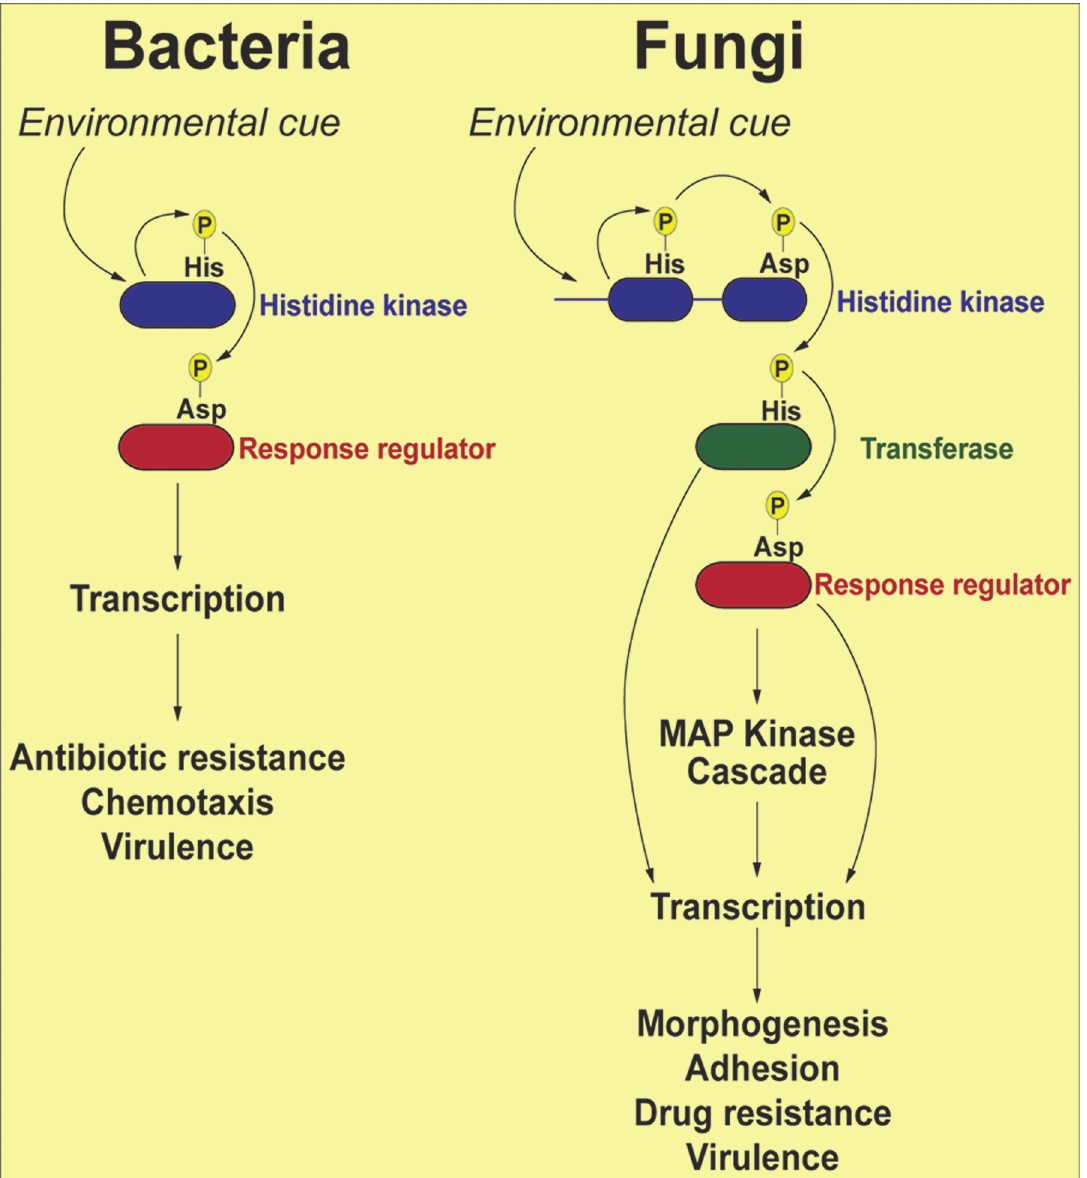
Fig 1. Schematic representation of two-component signal transduction pathways in bacteria and common human fungal pathogens. In response to environmental stimuli the histidine kinase (HK) is autophosphorylated on a histidine residue. In bacteria, the phosphate group from the histidine is transferred to an aspartate residue on a response regulator (RR), and the phosphorylated RR usually acts as a transcription factor to activate genes involved in response to the stimuli. In fungi, the phosphorelay involves three proteins: the phosphoryl group is first transferred intramolecularly from the histidine to an aspartate on the HK, then to a histidine on a transferase protein, and finally to an aspartate on a RR. The end result of these reactions is often activation of a downstream MAP kinase cascade, which, in turn, activates transcription factors whose target genes participate in the cellular response to environmental